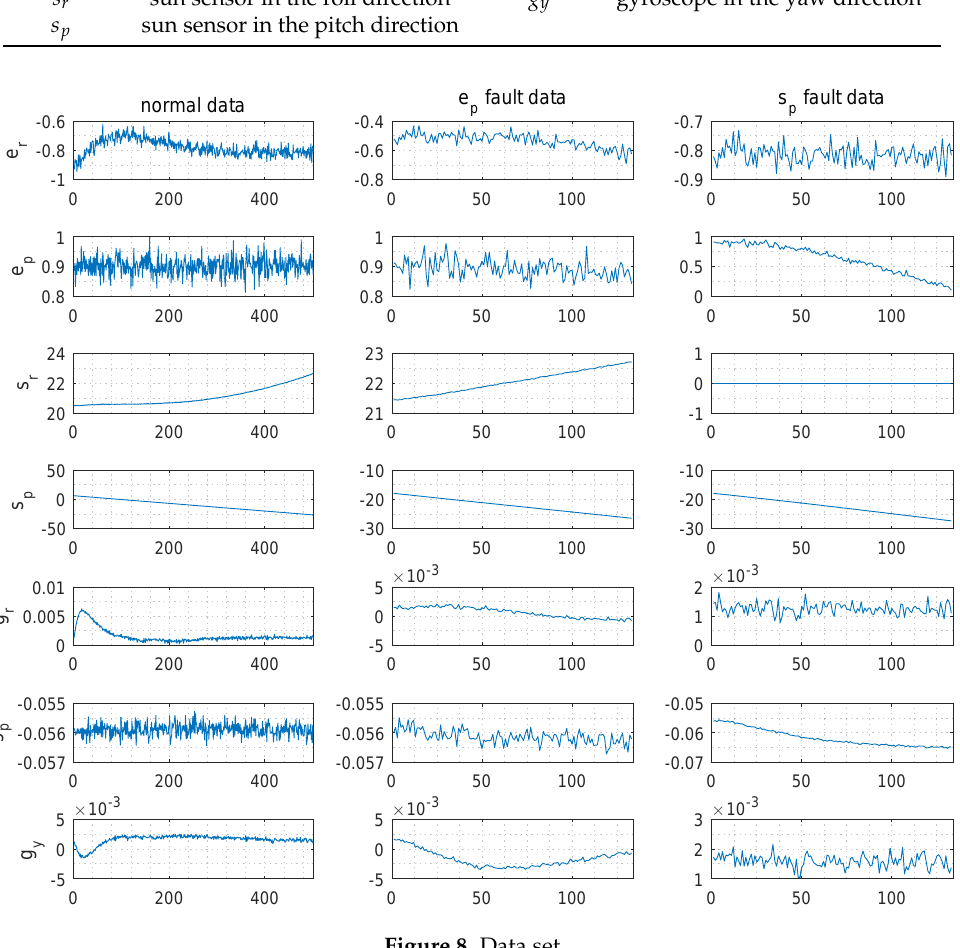
Figure 8. Data set.